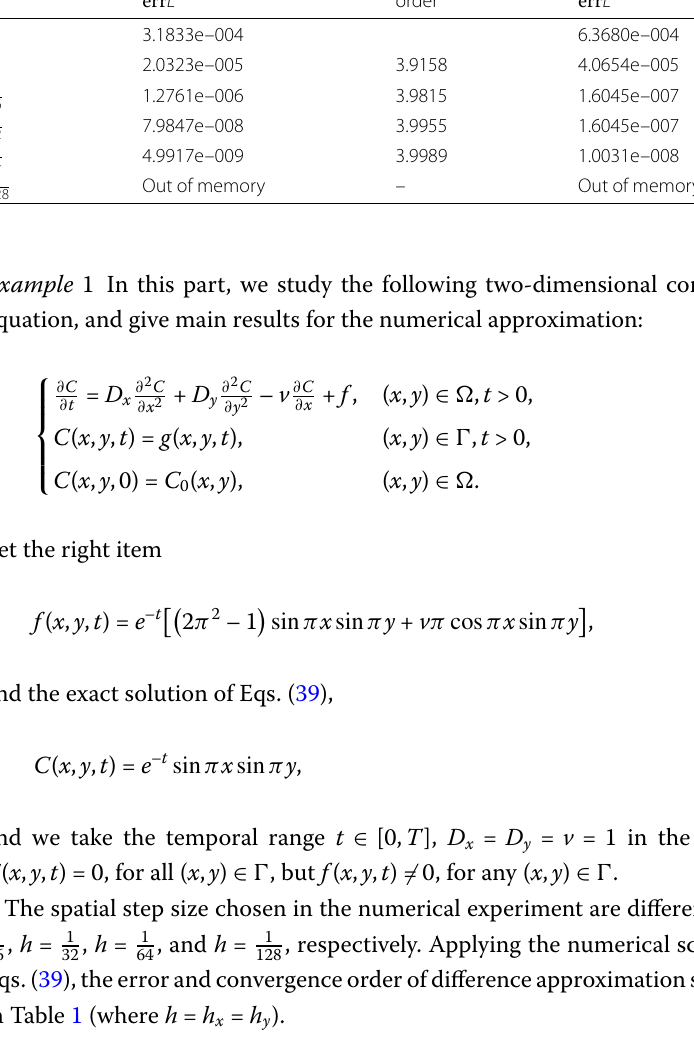
Table 1 The comparison of the l 2 -norm and the l ∞ -norm when τ 2 = h x = h y for O ( h 4 x + h 4 y ) fourth-order compact finite difference schemes in Example 1, at different values of the step size (for N = 4,8,16,32,64,128) in the x and y directions h err L 2 order err L ∞